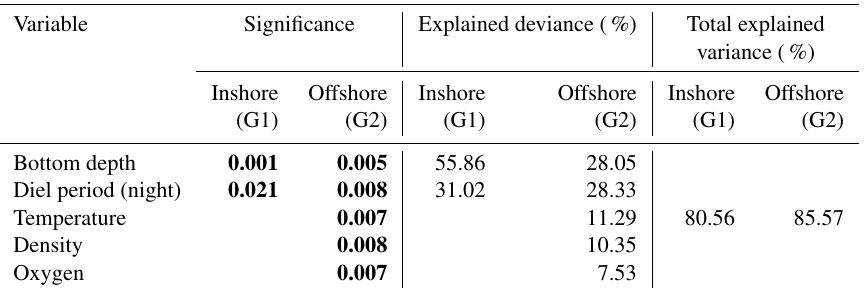
Table 2. Result of ANCOVA models between depth of sound-scattering layers (SSLs) and environmental parameters (temperature, density, dissolved oxygen, chlorophyll a , diel period, and bottom depth) in the inshore area (G1) and the offshore area (G2). G1: multiple R 2 is 0.8056, adjusted R 2 is 0.7797, and p value is 0.001; G2: multiple R 2 is 0.8557, adjusted R 2 is 0.7956, and p value is 0.000; significant p values in